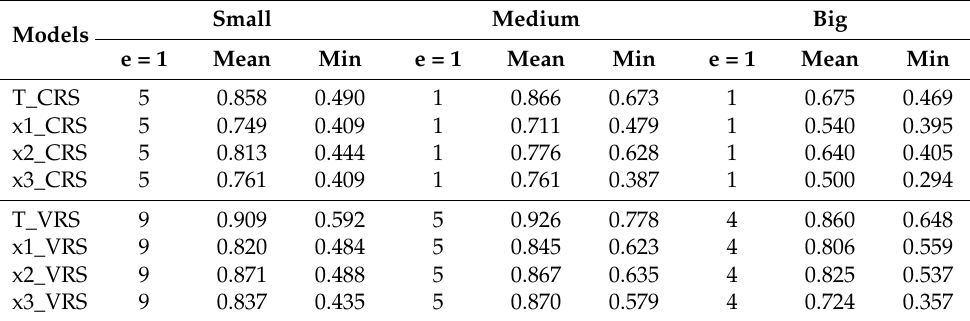
Table 6. Efficiency results according to the hospital size